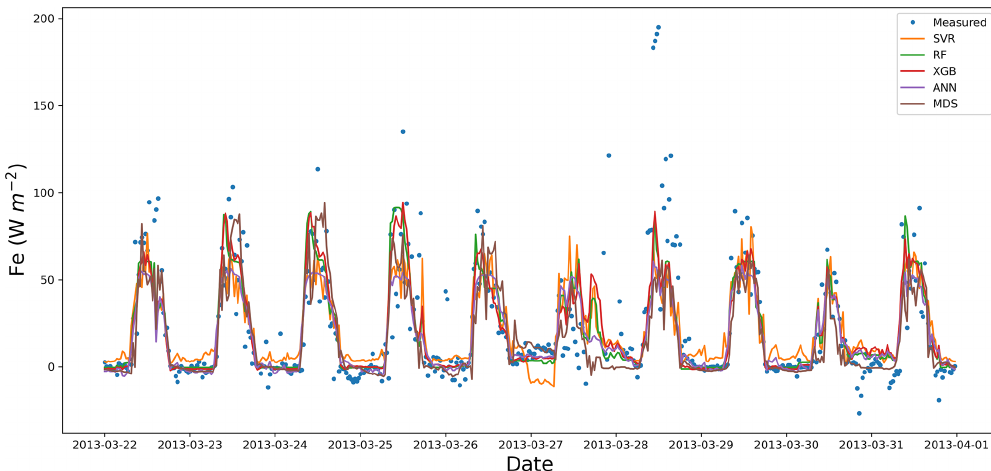
Figure 3. Measured vs. estimated values of F e for Calperum based on a 10d gap window (22–31 March 2013).